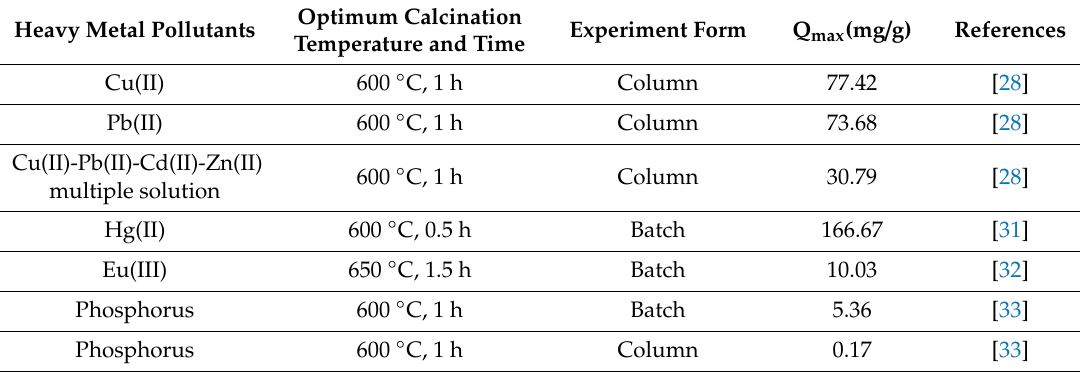
Table 1. Comparison of the adsorption capacities of MPy on di ff erent heavy metal pollutants. Heavy Metal